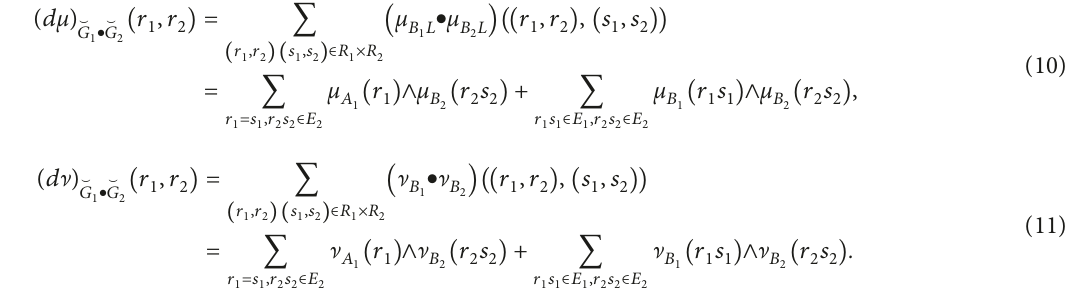
Figure 3: Semistrong product of two CuPFGs G ⌣